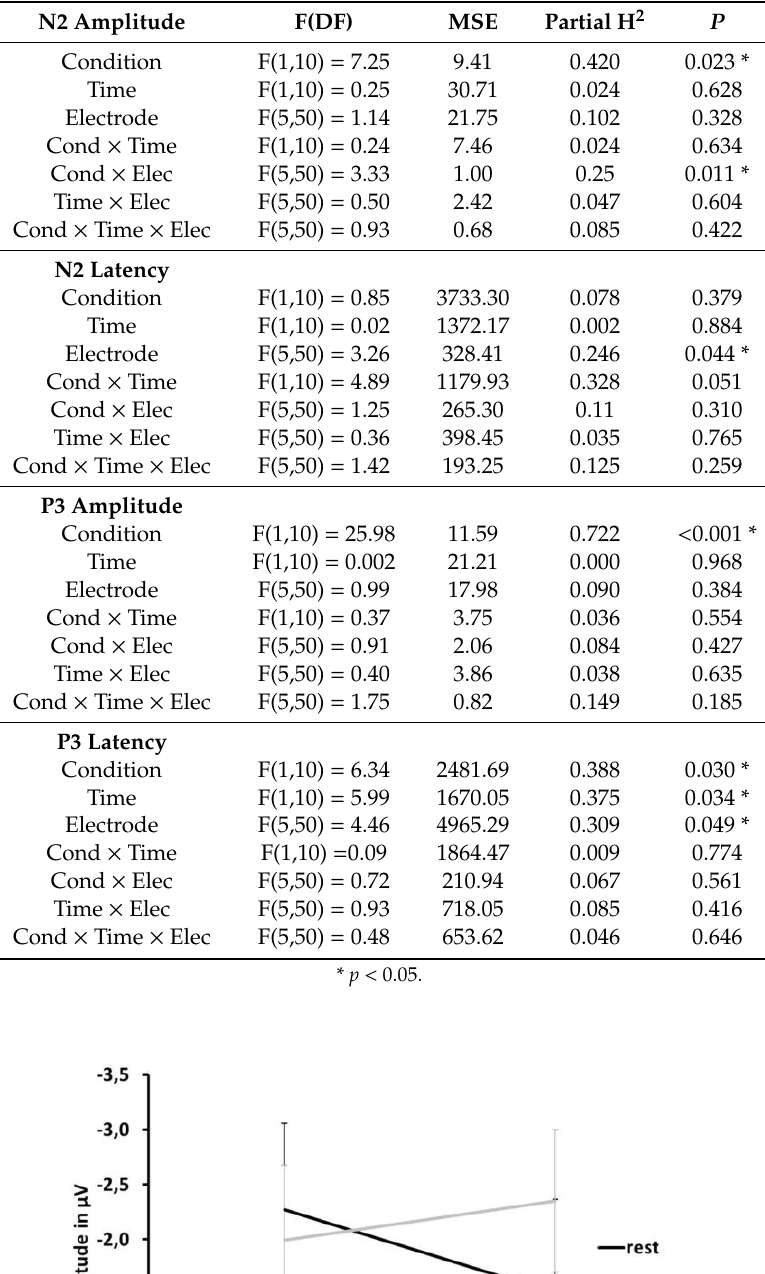
Table 4. Statistics on the analyses of amplitude and latency of the N2 and P3.